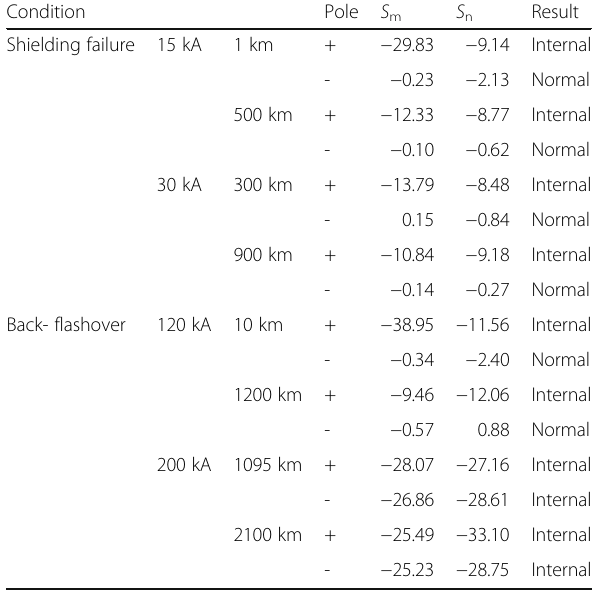
Table 9 Simulation results for lightning stroke causing faults Condition Pole S m S n Shielding failure 15